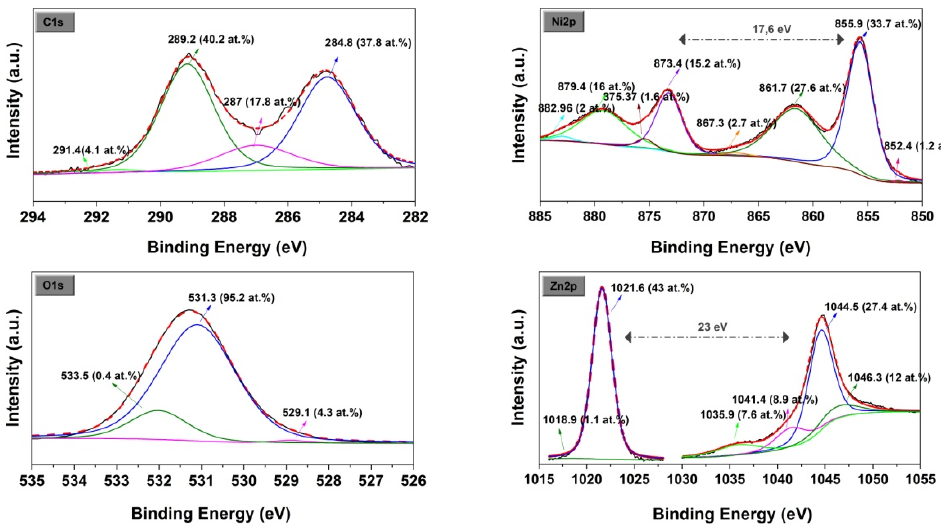
Figure 3. XPS spectra of the Ni/Zn LDH-based adsorbent in the Ni 2p , Zn 2p , C 1s , O 1s energy regions.